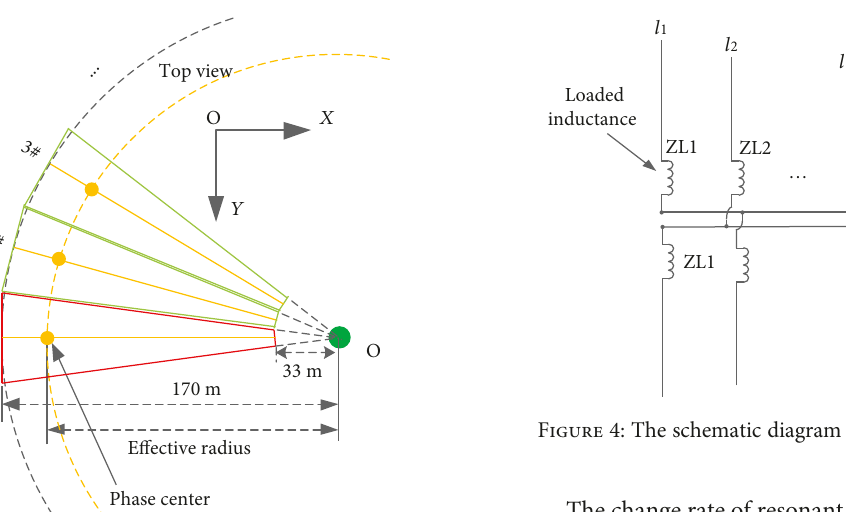
Figure 2: The scale factor and spacing factor of nonlinear LPDA change curve: (a) scale factor change curve ( τ change curve ( τ 0 = 0 86 and σ 0 = 0 051 ).